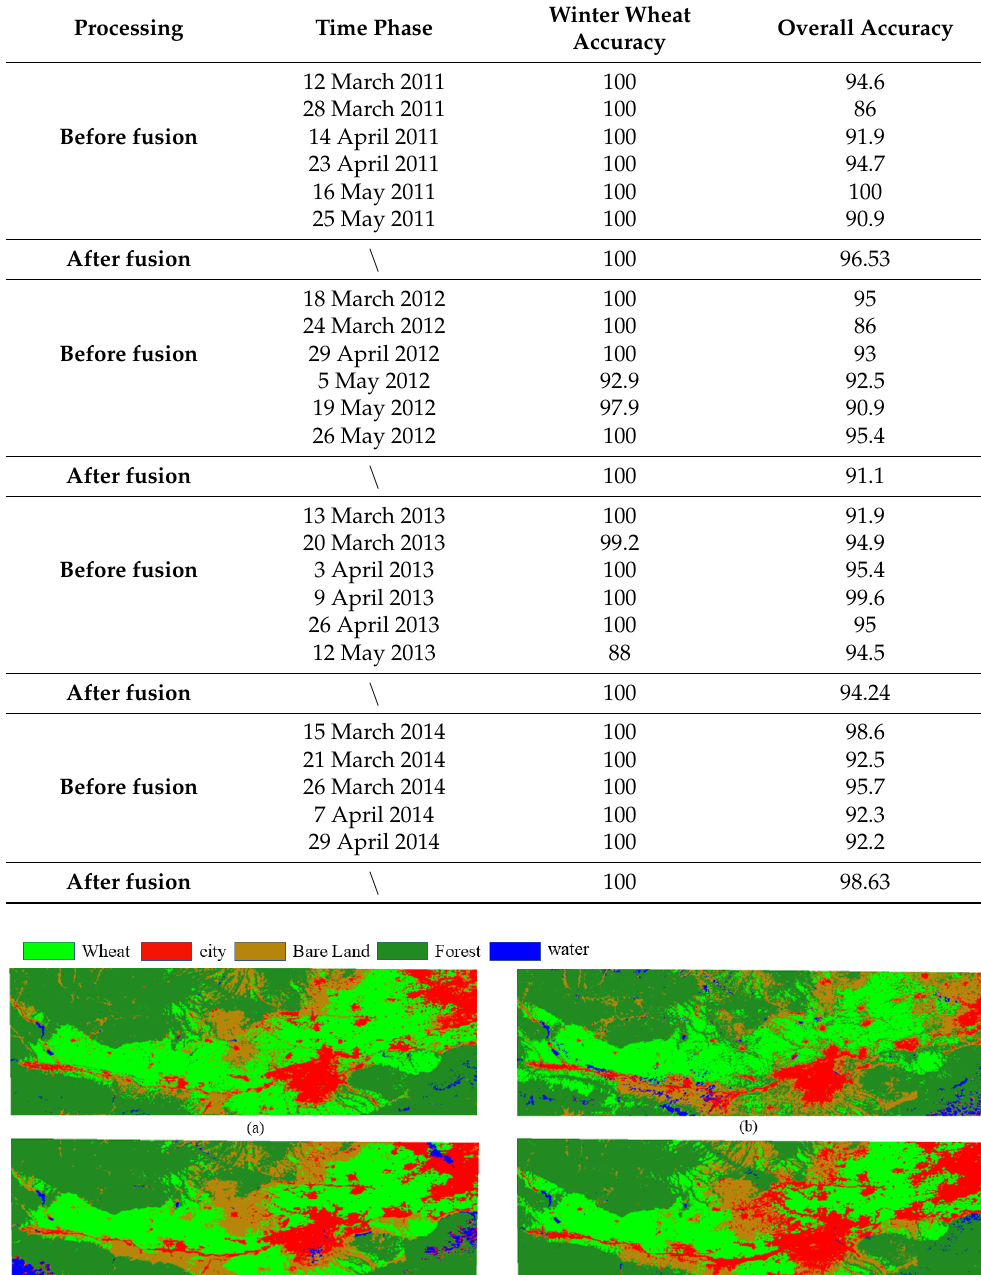
Table 2. Winter wheat before and after image fusion and overall extraction accuracy (%).